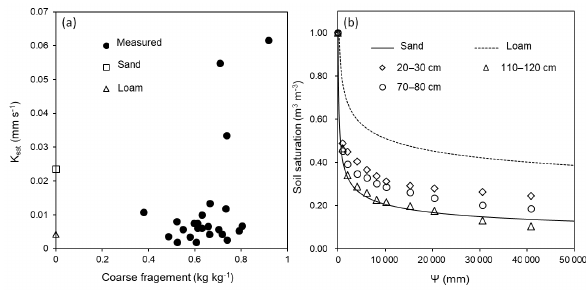
Figure 5. The relations between (a) saturated hydraulic conductiv- ity ( K sat , mms − 1 ) and coarse-fragment fraction (solid dots repre- sent measured values; empty circles and empty triangles represent the corresponding values of sand and loam used in the Commu- nity Land Model), and (b) soil saturation (m 3 m − 3 , lines) and abso- lute value of matric potential ( (cid:57) , mm H 2 O) at three representative depths (solid and dashed lines represent the default values (Oleson et al., 2010) of sand and loam).